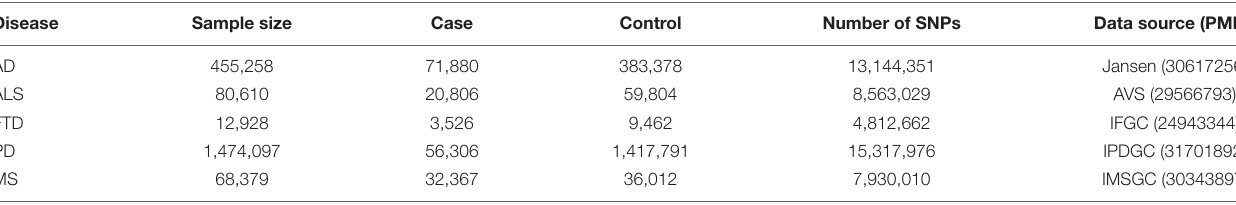
TABLE 1 | Genome-wide association study data sets of neurodegenerative diseases employed in our analysis.